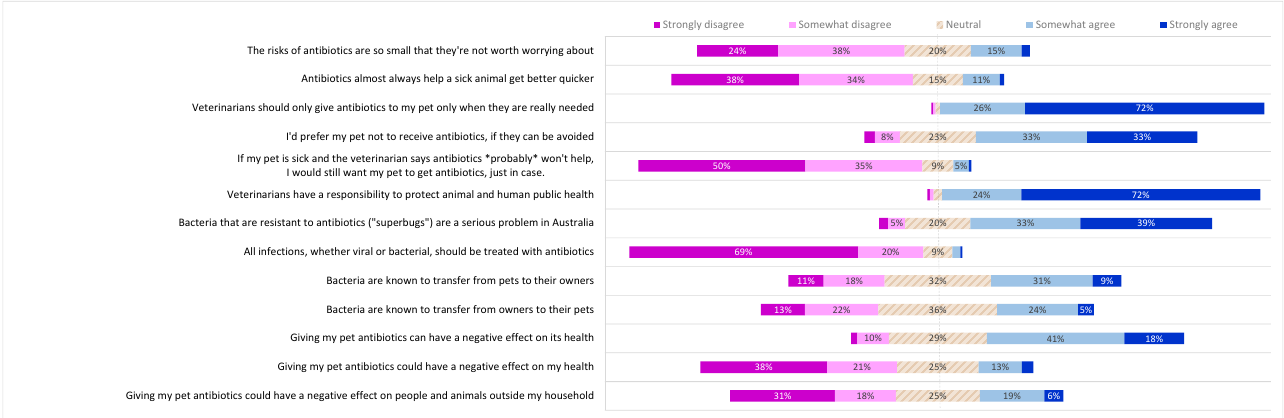
Figure 8. Pet owner opinions on antibiotic use; knowledge of microbiology and antibiotic resistance. Pet owners were asked to what extent they agreed with each statement on the left. Proportions of responses to each statement corresponding to each of the five points of the Likert scale are shown. Data labels omitted where value is <4%.